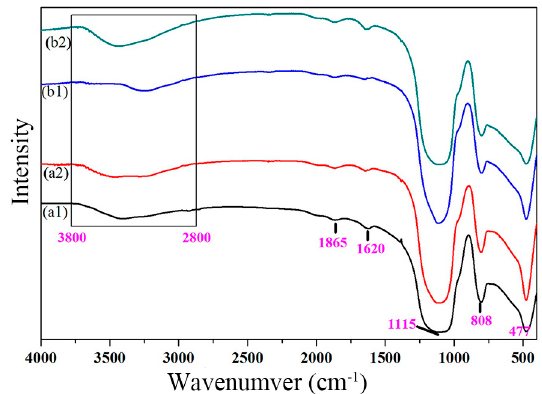
Figure 4. Fourier transform infrared spectroscopy (FT-IR) spectrum of the SiO 2 –TiO 2 with different TiO 2 ratios. ( a1 ) SiO 2 –TiO 2 -20, before UV irradiation; ( a2 ) SiO 2 –TiO 2 -20, after UV irradiation; ( b1 ) SiO 2 –TiO 2 -30, before UV irradiation; and ( b2 ) SiO 2 –TiO 2 -30, after UV irradiation; The black rectangle region represents the absorption bands caused by the vibration of the hydroxyl radical